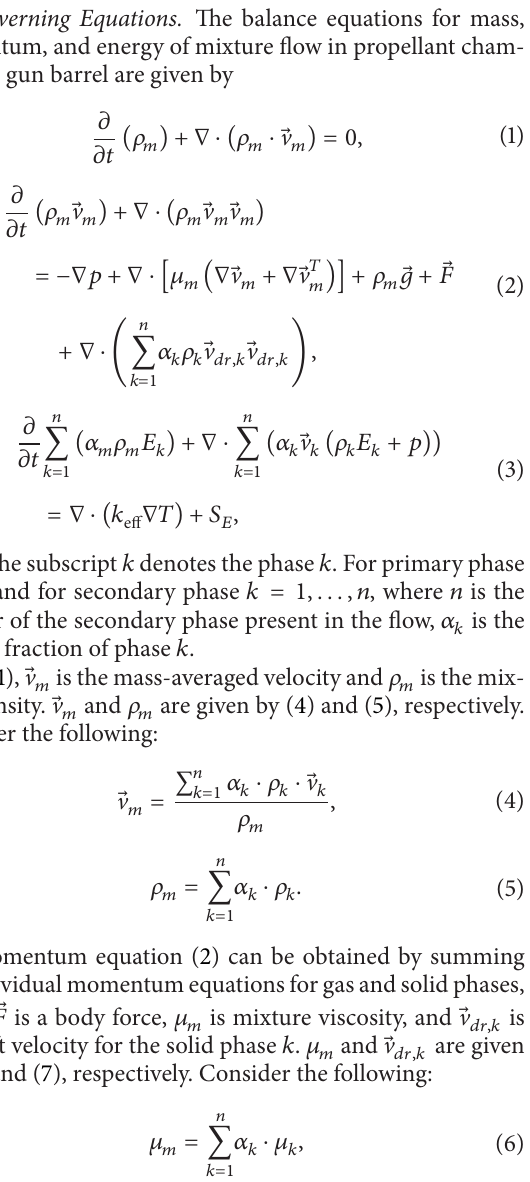
Figure 1: Initial geometry configuration in small